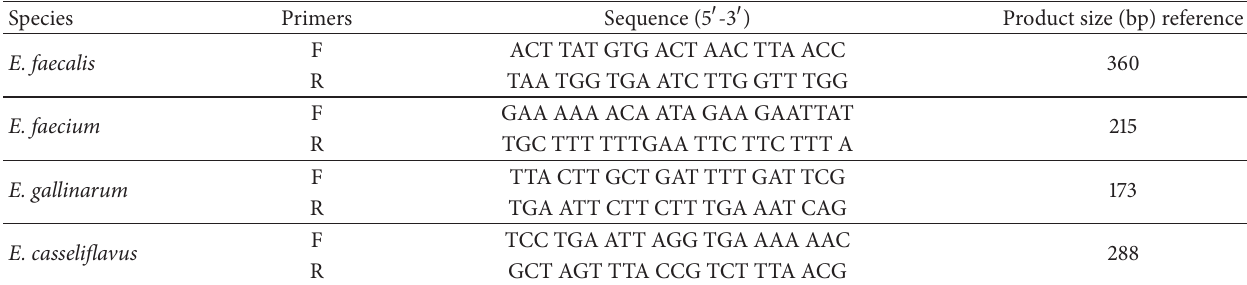
Table 1: PCR primers used in this